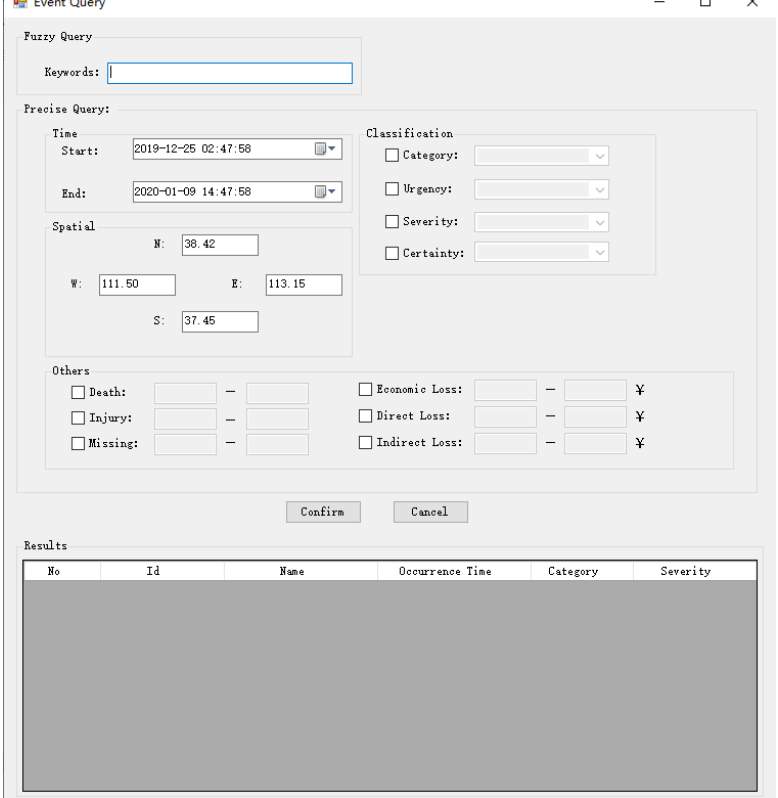
Figure 4. Urban fire event query function module